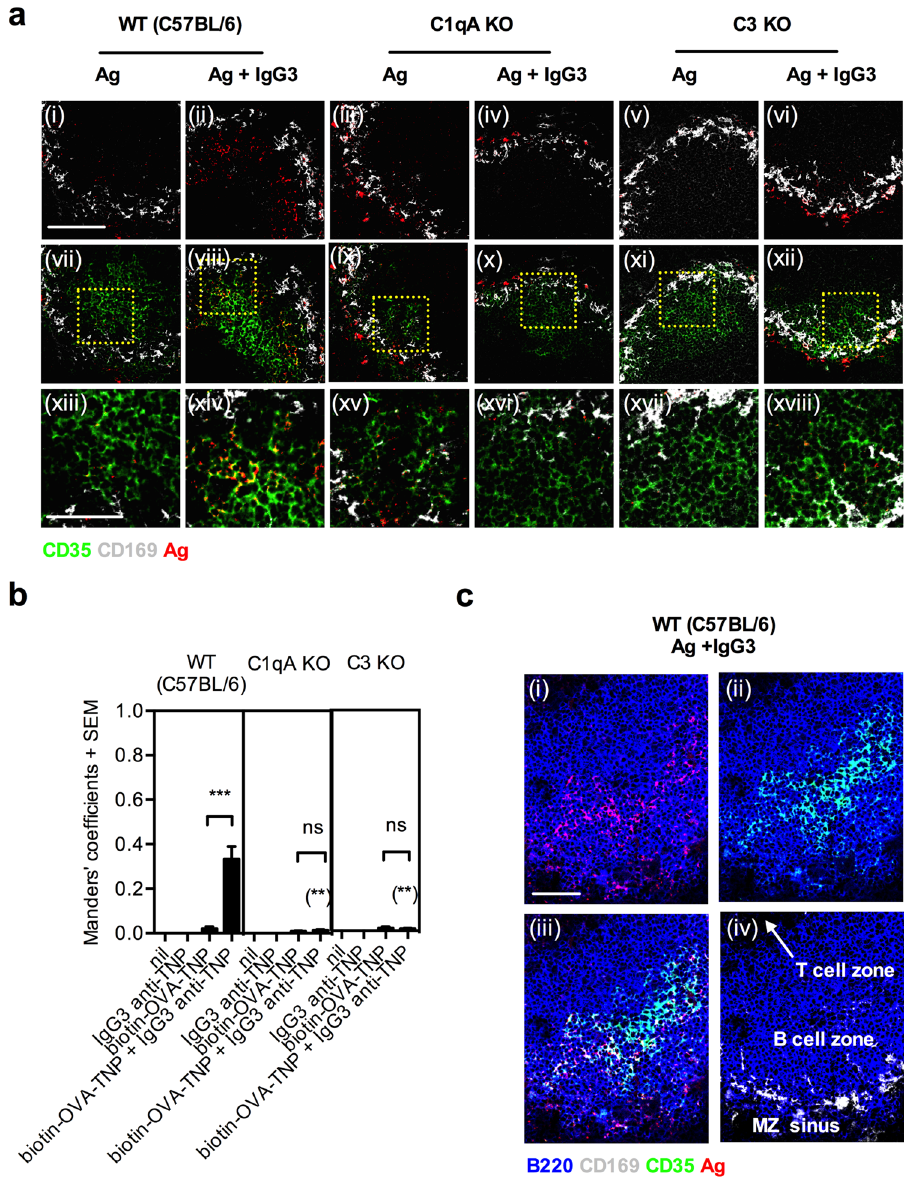
Figure 3. IgG3-mediated antigen deposition on FDC is impaired in mice lacking C1q or C3. Spleen sections from WT (C57BL/6), C1qA KO, and C3 KO mice described in Fig. 2 were here stained with rat anti-mouse CD35/CR1 for 1 h, followed by PE-labeled goat anti-rat IgG (FDC; green) for 1 h, blocked with 5% rat serum for 30 min, and then stained with a mixture of anti-mouse B220-Pacific blue (B cells; blue), anti-mouse CD169-FITC (metallophilic macrophages; grey) and SA-APC (antigen; red) for 1 h. One longitudinal section from each half spleen was analyzed by confocal microscopy. ( a ) (i–xii) Images show representative FO areas (250 μ m × 250 μ m, scale bar = 100 μ m) of 4–5 follicles per mouse. (i–vi) Antigen and metallophilic macrophages are shown. (vii–xii) Antigen, metallophilic macrophages, and FDC are shown. (xiii–xviii) Magnifications (94 μ m × 94 μ m, scale bar = 50 μ m) of the fields indicated by dotted squares in vii–xii. ( b ) Quantification of the fraction of total FDC area staining positive also for antigen (antigen + FDC area/total FDC area) is shown as Manders’ coefficients + SEM. ( c ) Representative images (200 μ m × 250 μ m, scale bar = 50 μ m) of a follicle from a C57BL/6 mouse immunized with IgG3 anti-TNP and biotin-OVA-TNP. (i) B cells and antigen are shown. (ii) B cells and FDC are shown. (iii) B cells, FDC and antigen are shown. (iv) Outline of a follicle indicated by B cells and metallophilic macrophages (anti-CD169 staining). Data are representative of three independent experiments (two with clone IM-F10 and one with clone IM-H11) and are shown as mean + SEM. The p values for comparisons of the responses in mice immunized with antigen alone or with IgG3-antigen complexes are indicated without parentheses. The p values for comparisons of responses in WT versus C1qA or C3 KO mice immunized with IgG3-antigen complexes are indicated within parentheses. ns, p > 0.05; * p < 0.05; ** p < 0.01; *** p <